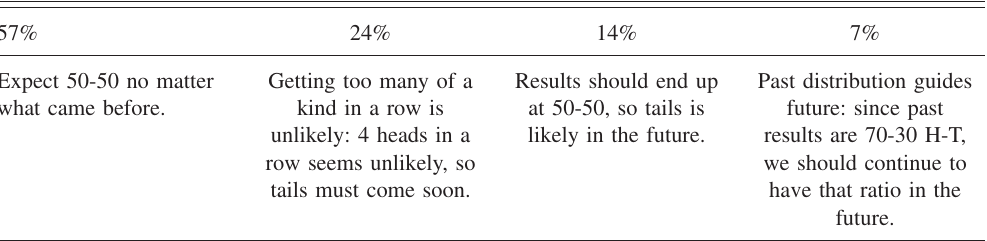
TABLE II. Student responses and typical explanations on the 11th coin toss problem. N =42. One student gave two different explanations, so totals do not add to 100%.